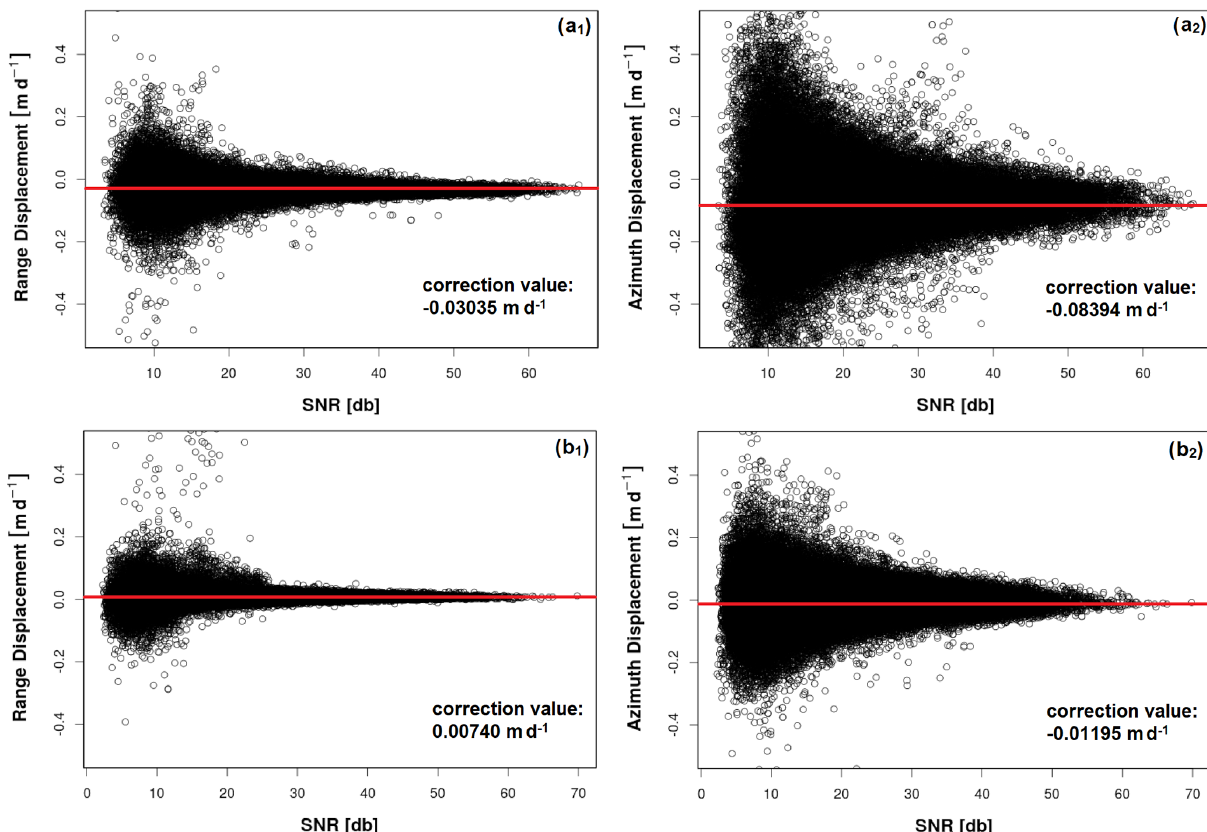
Figure 4. Determination of coregistration error correction values. Coregistration error correction values in az and r direction are shown for the velocity fields from 15 January 2019 (a1, a2) and 11 August 2019 (b1, b2) displayed in Fig. 3. Black circles represent displacement values extracted over stable ground, plotted against their corresponding SNR (signal to noise ratio) values and computed as SNR = CCP / CCS. The median displacement values (red lines) coincide well with the displacement values that have the highest SNR values (i.e., the most reliable measurements, assumed to be primarily affected by coregistration inaccuracy). After correction, median displacement values are 0 for both